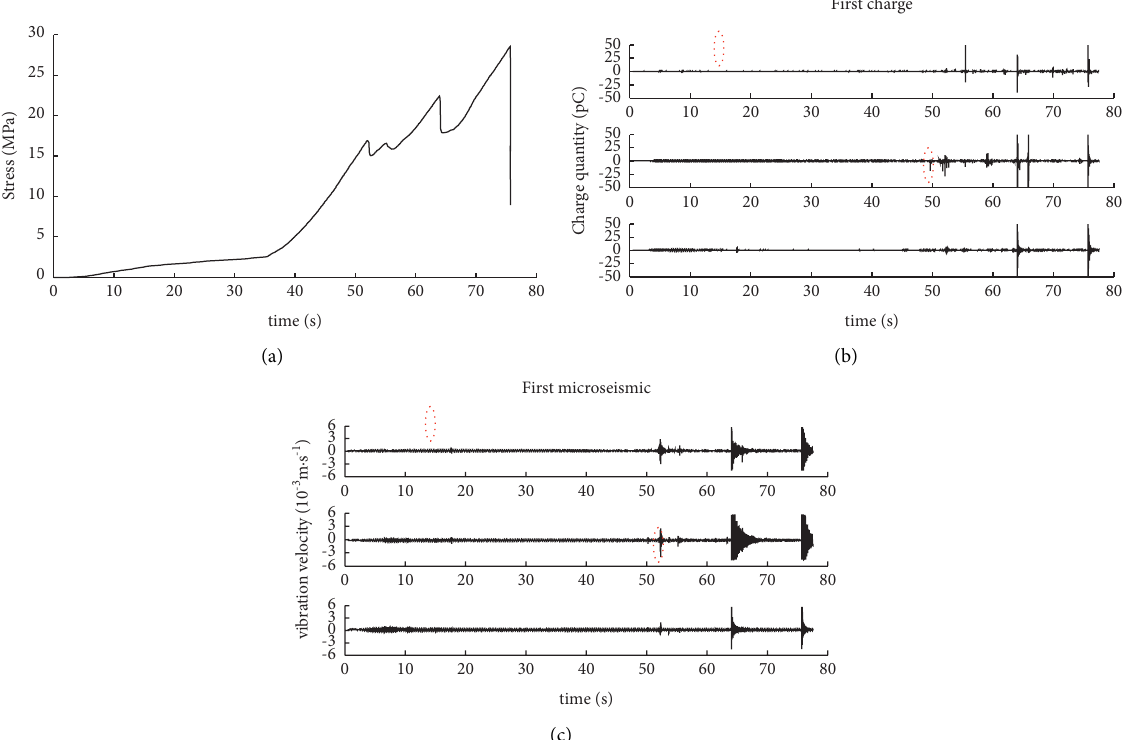
Figure 6: Charge induction and microseismic signals of sandstone when loading rate is 0.05mm/s. (a) Stress curves. (b) Charge induction signals curves. (c) Microseismic signals curves.